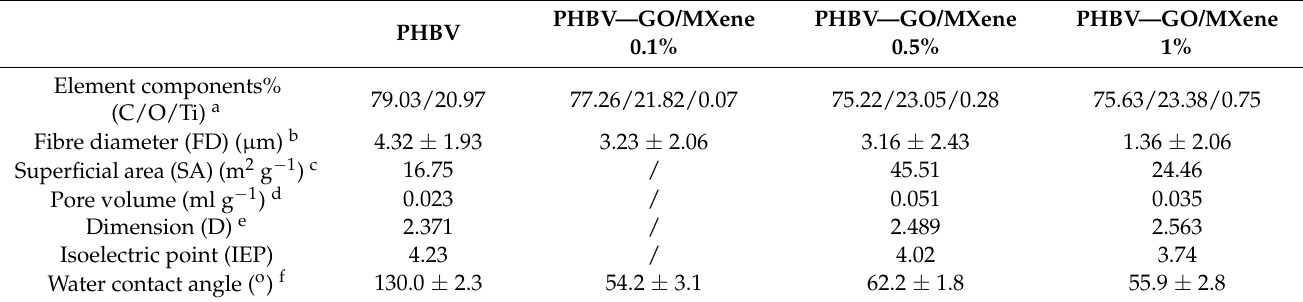
Table 1. The element composition and properties of PHBV and PHBV—GO/MXene composite